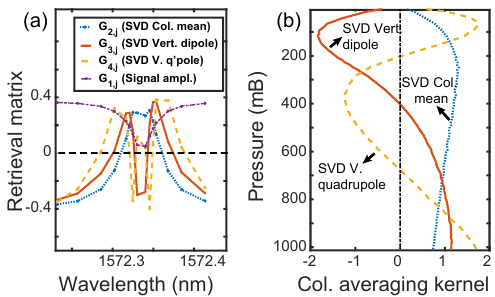
Figure 3. SVD retrieval basis: (a) the rows of the G matrix are plot- ted as a function of the wavelength of the measurement samples. (b) The averaging kernels of the first three CO 2 principal compo- nent terms are plotted. Each subsequent term has an additional zero crossing in the averaging